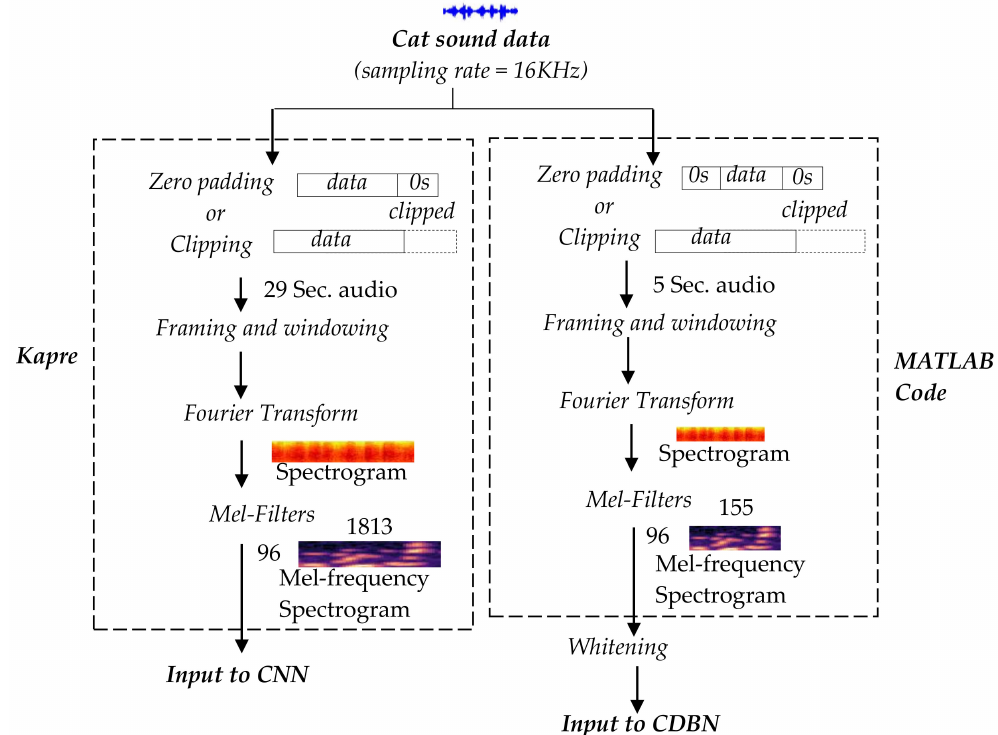
Figure 3. Preprocessing of the input data for the convolutional neural network (CNN) ( left ) and convolutional deep belief network (CDBN) ( right ). For the CNN input data, all the preprocessing is made using Kepre and short audio data are padded with zeros only on the right side. The MATLAB code is used for CDBN input preprocessing and the short audio data are padded with zeros on both sides. Finally, whitening is carried out at the